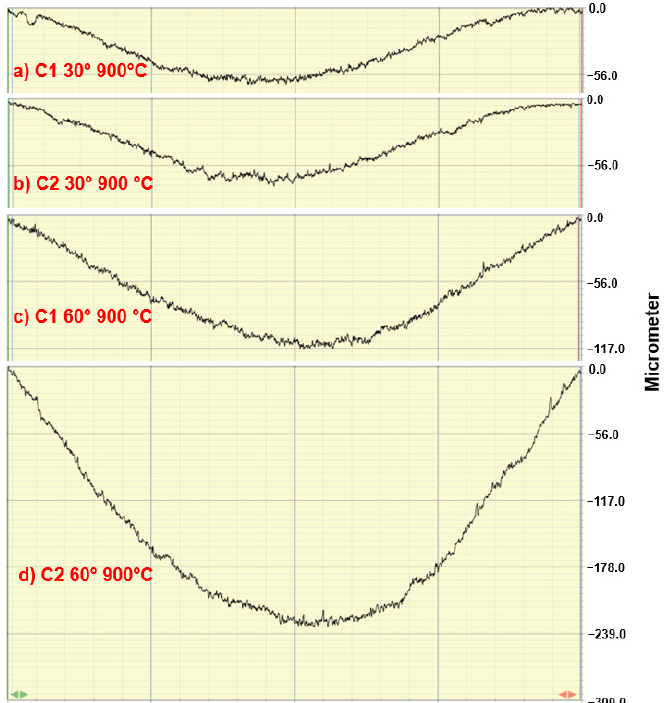
Figure 10. Profilometry plot of maximum penetration: ( a ) C1 30 ◦ 900 ◦ C; ( b ) C1 60 ◦ 900 ◦ C; ( c ) C1 Figure 10. Pro fi lometry plot of maximum penetration: ( a ) C1 30° 900 °C; ( b ) C1 60° 900 °C; ( c ) C1 30° RT; and ( d ) C2 60° 900 °C. (units in micrometers). 30 ◦ RT; and ( d ) C2 60 ◦ 900 ◦ C. (units in